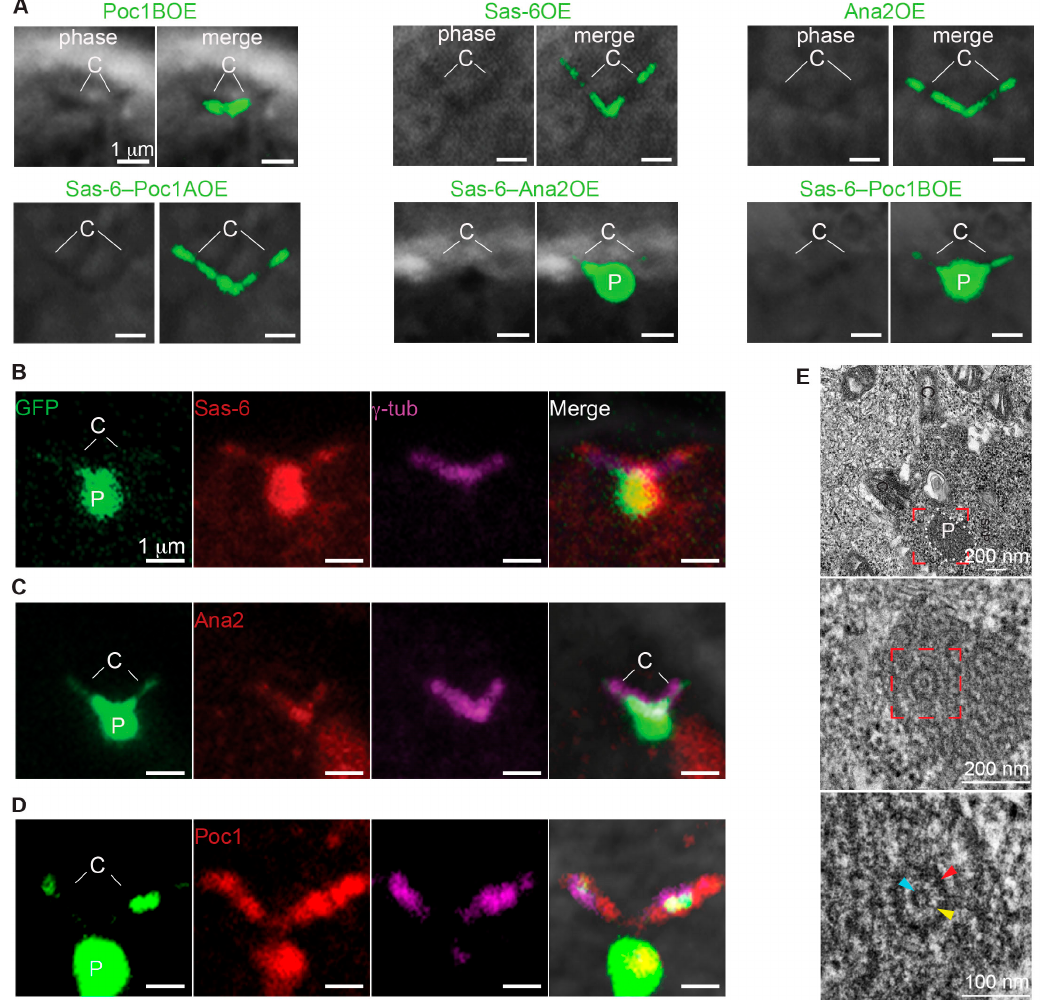
Figure 6. Co-overexpression of Poc1B and Sas-6 is sufficient to induce formation of PCL-like structures. ( A ) Co-overexpression of either Sas-6GFP–Ana2GFP or Sas-6GFP–Poc1BGFP induced the particles in primary spermatocyte. No particles were observed in co-overexpression of Sas-6GFP– Poc1AGFP or in overexpression of any of the tested proteins alone. ( B – D ) Sas6/Poc1B Particles were attached to the γ -tubulin labeled centrioles, Sas-6 antibodies labeled the particles and the centrioles tip ( B ), Ana2 antibodies labeled the centrioles (C), and Poc1 antibodies labeled the particles and centrioles ( D ). ( E ) Sas6 / Poc1B Particles were composed of PCL-like structures in mature